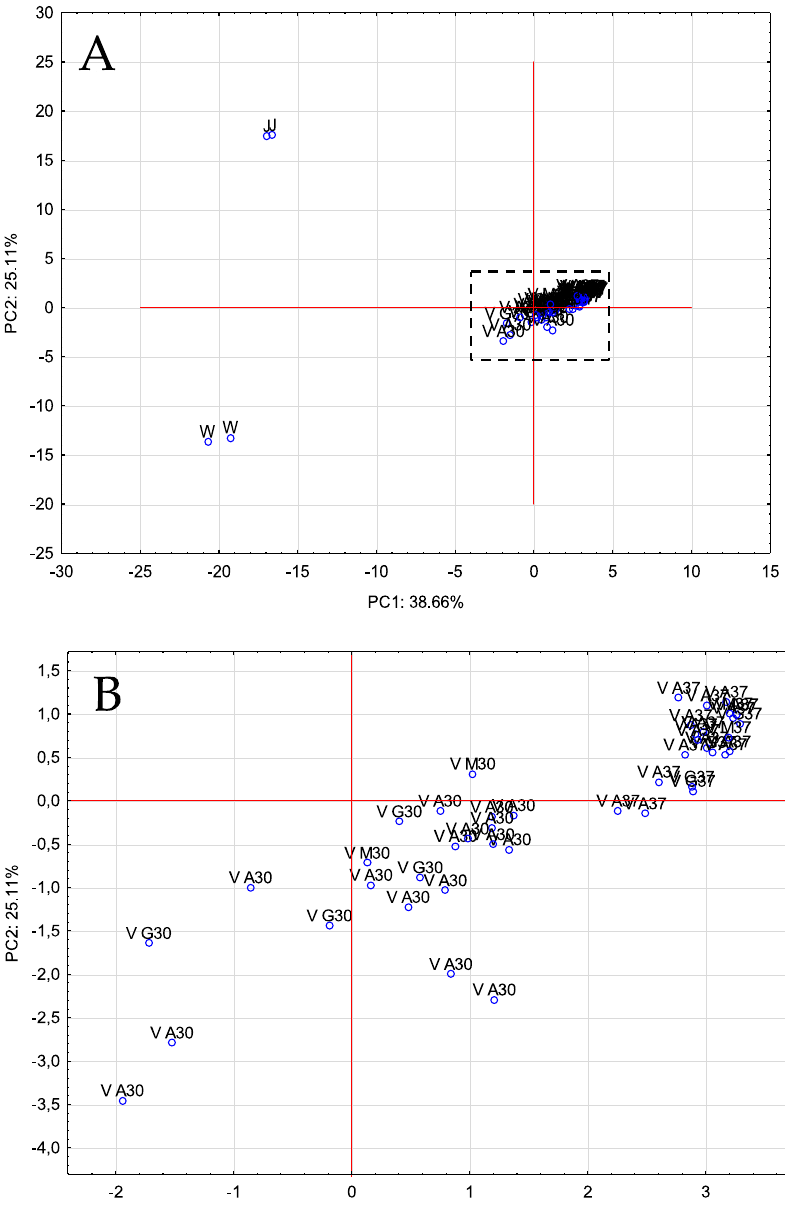
Figure 1. PCA of volatile compounds. Distribution of all samples onto the plane defined by the first two PCs. ( A ): original graph; ( B ): zoomed area. J: prickly pear juice; W: prickly pear wine; V: prickly pear vinegar.